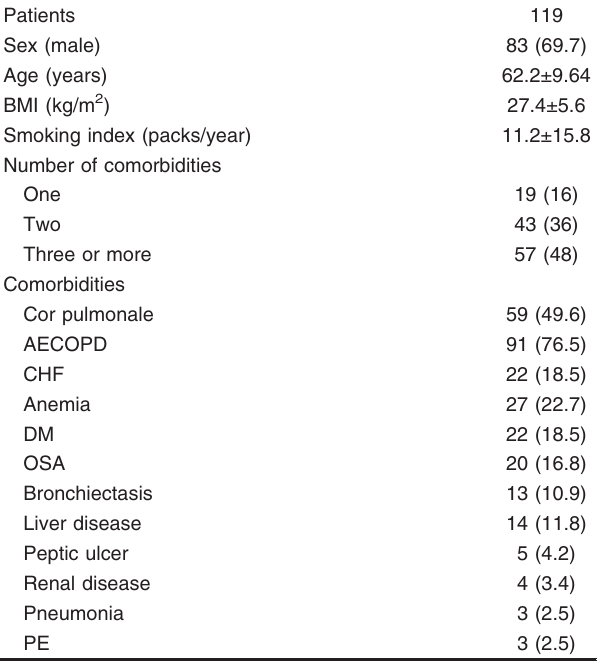
Table 1 Patient characteristics and underlying conditions